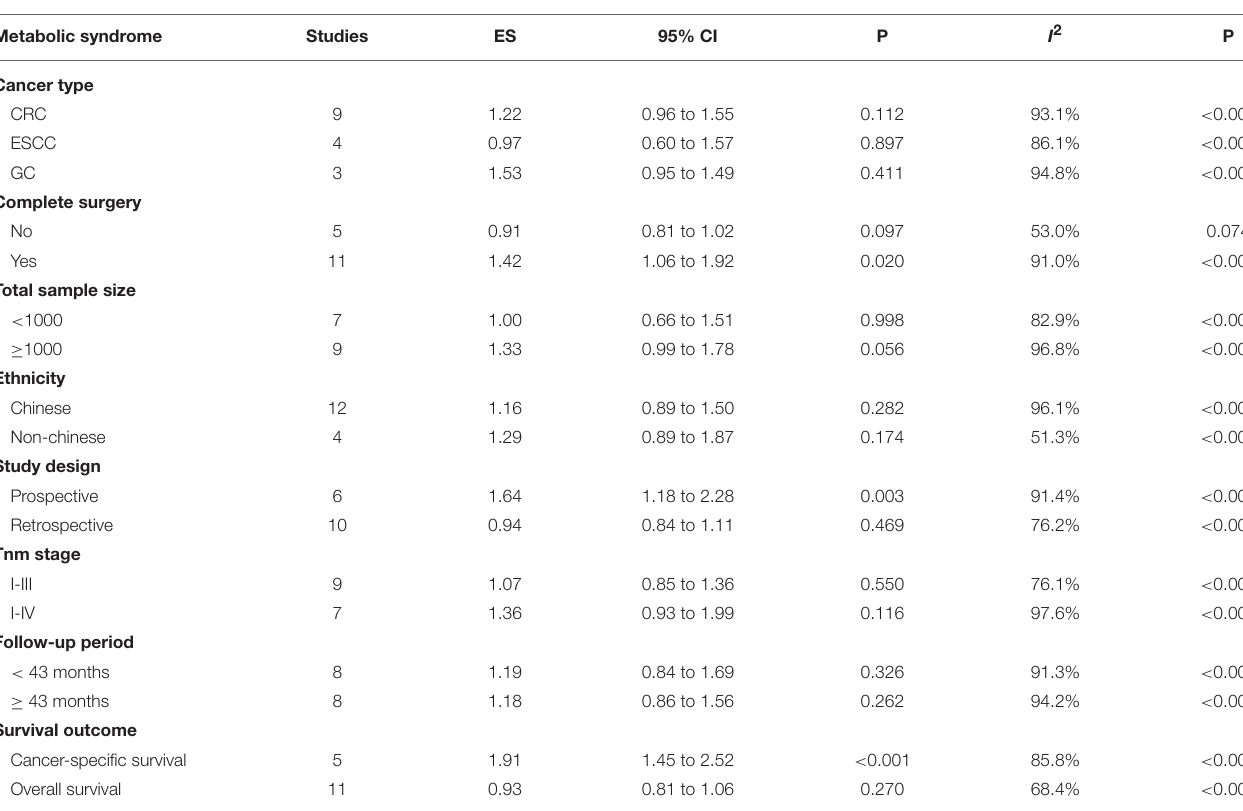
TABLE 3 | Stratified risk estimates of metabolic syndrome for the survival of digestive tract cancer. Metabolic